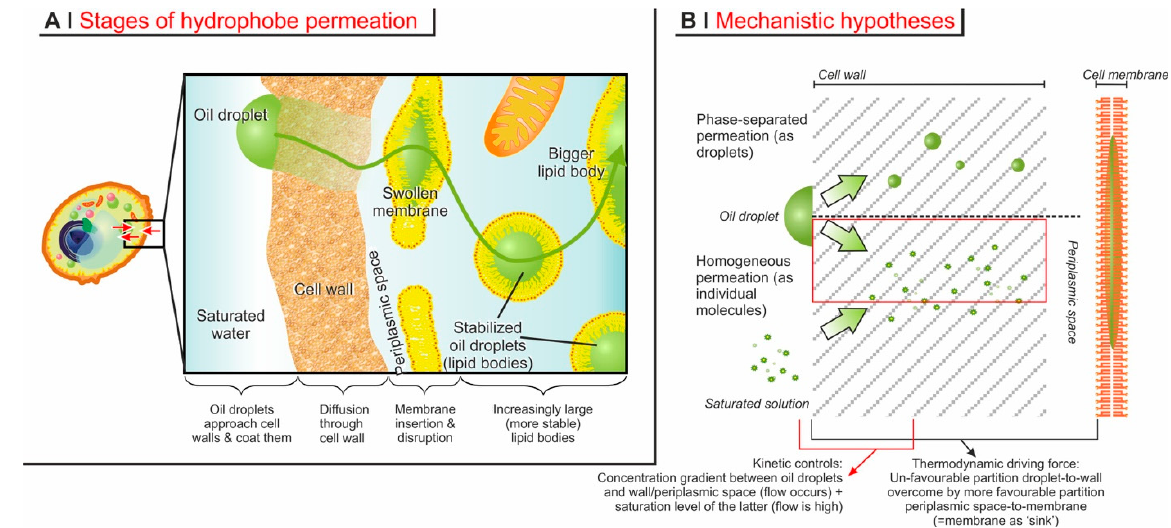
Figure 4. ( A ). The process of diffusional encapsulation of hydrophobes into an (intact) yeast cell can be broken down into adsorption on the wall, permeation through the cell wall and periplasmic space, penetration in the cell membrane, and finally the disruption of the latter (and of all other membrane-limited organelles) to form large lipid bodies. ( B ). Mechanistically, it could be hypothesized that the hydrophobes permeating through cell wall do so both from adsorbed droplets and from the (saturated) external solution, or that they pass the membrane as small hydrophobic aggregates or as individual molecules. Experimental evidence and simple considerations lead to the conclusion that the hydrophobes should permeate as individual molecules originating from oil droplets (highlighted in the red box). Furthermore, there are two main partition equilibria: from adsorbed droplets to the cell wall, and from the periplasmic space to a (swollen) membrane/lipid body; the stabilization offered by the cell surfactants to the latter is likely the main thermodynamic driving force of the whole process.